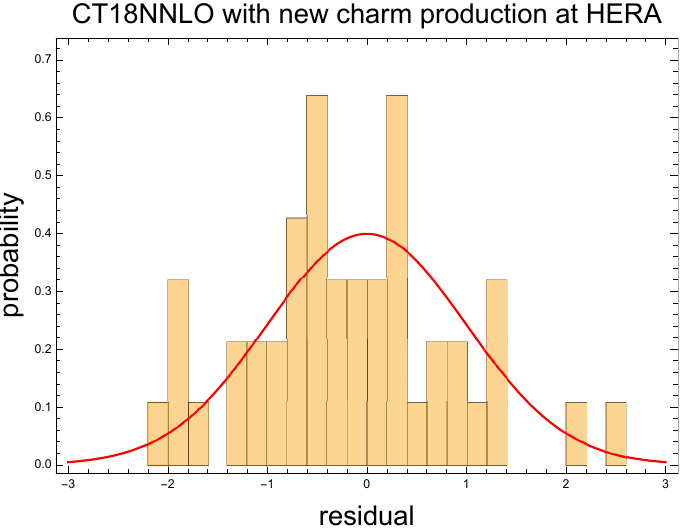
Figure 2: Ratio to the CT18XNNLO gluon PDF as a function of x at Q = 2 GeV and = 1 GeV. Left: scan over the MS charm-quark mass m Q 0 GeV. Right: scan over the B parameter in µ confidence level for CT18NNLO (red) and CT18XNNLO (blue).